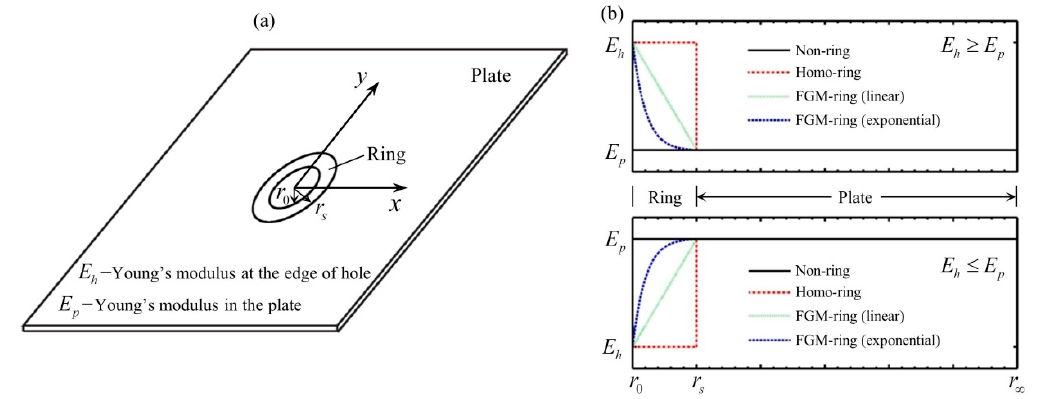
Figure 5. ( a ) A homogeneous thin plate with a circular hole reinforced with a ring; ( b ) variation of Young’s modulus along the radial direction for four types of the ring.